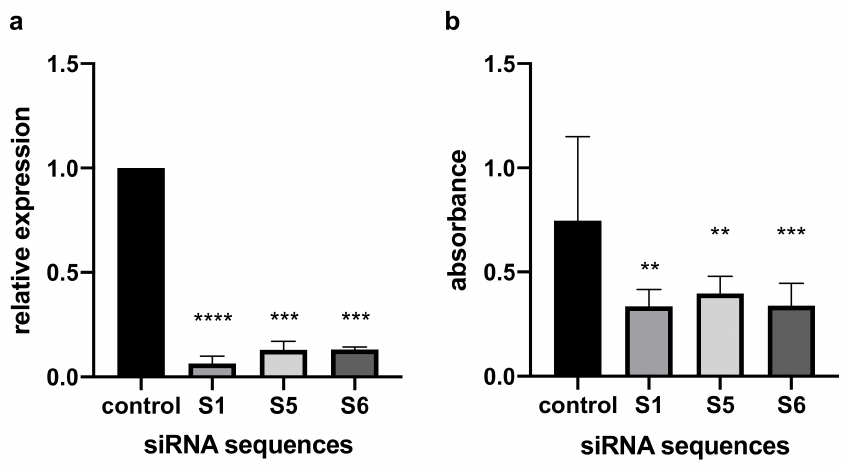
Figure 3. PAFR siRNA knockdown reduces proliferation of UWB1.289 ovarian cancer cells. ( a ) The upregulation of PAFR gene expression was significantly decreased by the three different siRNA sequences used, as shown by RT-qPCR. ( b ) Compared to the UWB1.289 cells with increased PAFR expression, the PAFR knockdown cancer cells proved to proliferate significantly less. Results are represented as mean (SD) of 3 independent experiments. One-way ANOVA was employed to test for differences between groups and indicated as ** p ≤ 0.01, *** p ≤ 0.001, and **** p ≤ 0.0001 compared with